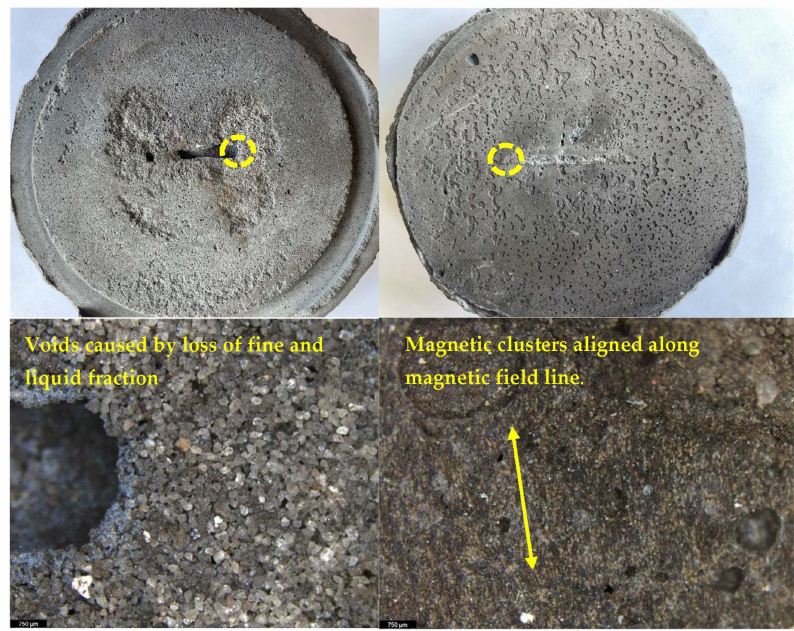
Figure 12. Hardened surface after the test: ( left ) no magnetic field application; ( right ) magnetic field of 0.65 T